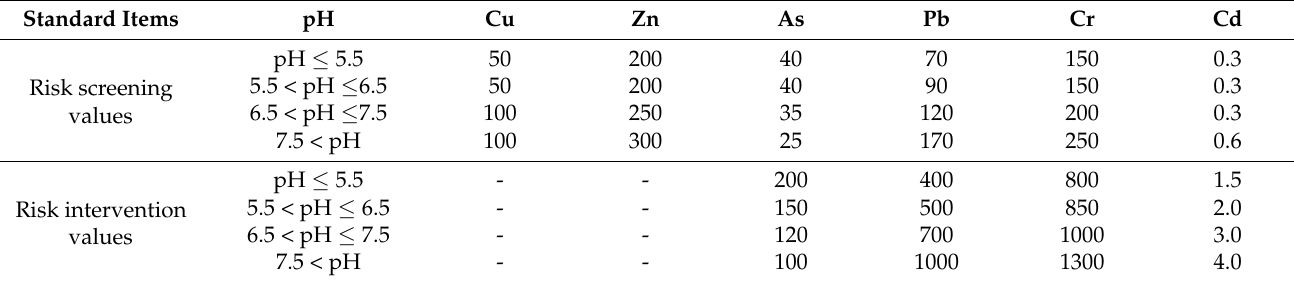
Table 1. Soil environment quality risk control standards